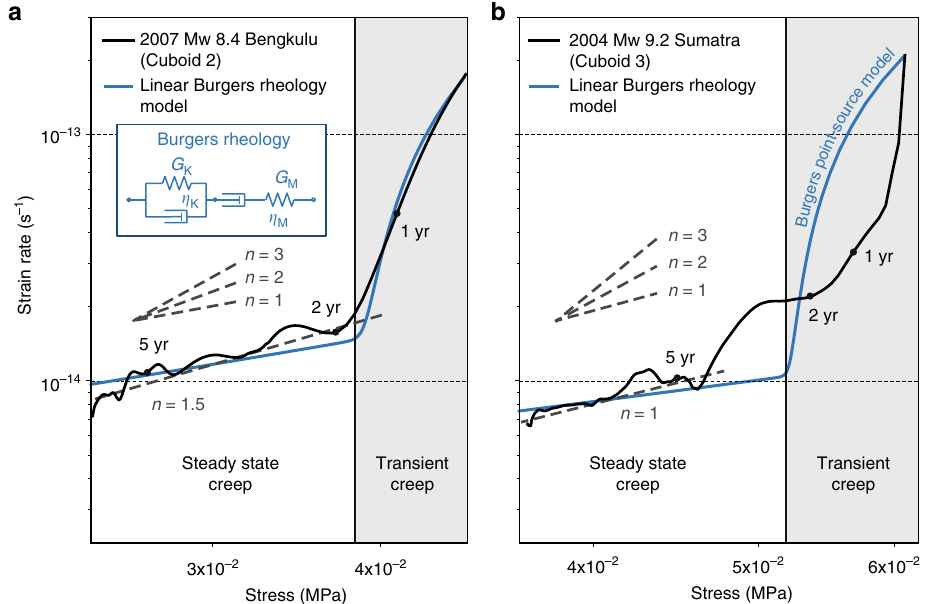
Fig. 8 Strain rate and stress relationship for well-resolved example cuboids 2 and 3. a , b Cuboid 2 locates directly down dip of the 2007 M w 8.4 Bengkulu earthquake, and cuboid 3 sits down dip of the 2004 M w 9.2 Sumatra – Andaman earthquake, respectively (Fig. 6). Grey dashed lines represent the power exponents of strain rate to stress. The black dots indicate the state 1, 2 and 5 years after the earthquakes. The blue curves are the theoretical response of a Burgers spring-dashpot model under constant loading and a stress height signals that would be captured by the tide gauges are absent in the coarse because the least-squares method estimates constant seasonal parameters for the altimetry Aviso grids. These localised signals would then be mapped into the land- whole-time period of each tide gauge. Using this technique we fi nd that the height time series, potentially producing abnormalities in the land-height variation seasonal signals for each month can vary considerably. We show one example of when compared to neighbouring tide gauges that were less affected by the local seasonal signals from both Aviso and the tide gauges at Johor Baru (location shown signals. For example, the high rate of subsidence at tide gauge BPAK-Bang Pakong in Fig. 2) in Supplementary Fig. 12. (Fig. 2) is comparable or even larger than that of tide gauge TAPN- Ko Taphao Noi We minimised the uncertainty by carefully removing the variable seasonal (Fig. 2), which was closer to the 2004 Sumatra – Andaman earthquake, and strongly signals, and by fi nding the collocated tide gauge and Aviso grids pairs. However, affected by the postseismic deformation process (Supplementary Fig. 5). This there are a number of uncertainties that are still contained within the resultant abnormally high rate of subsidence likely contains contamination from human- land-height time series due to the low-spatial resolution of the Aviso grids. For induced subsidence at Bangkok, Thailand (see refs. 59,60 ), ~50km away. Tide-gauge example, the local complexities of shallow bathymetric effects and manmade land-